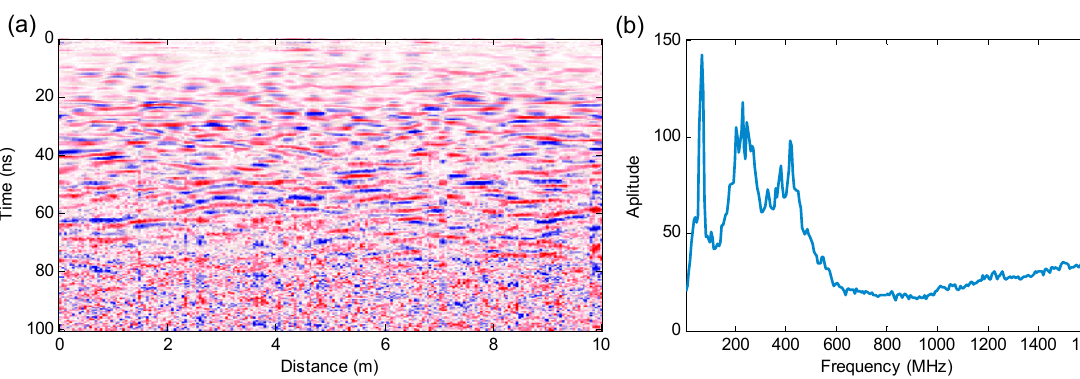
Figure 5. The route of Yutu lunar rover, the distance from N104 to N105 is the research route (10 m).